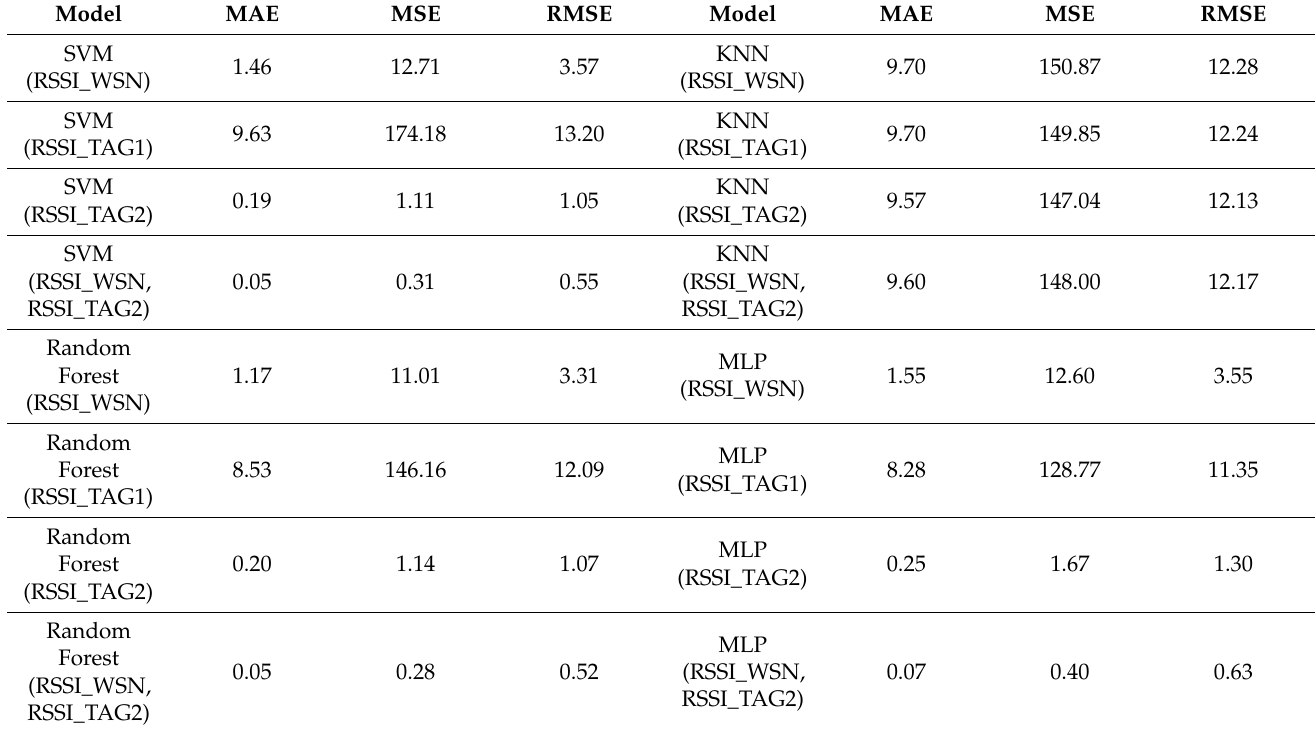
Table 9. MAE and RMSE for different